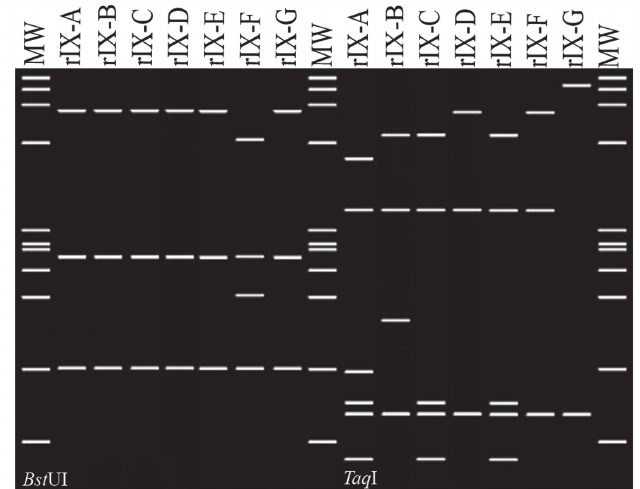
Figure 2 . Virtual R16F2nR2 RFLP patterns by key enzymes Bst UI and Taq I for distinguishing among 16SrIX sub- groups. MW, FX174DNA digested by Hae III, fragment size (bp) from top to bottom: 1353, 1078, 872, 603, 310, 281, 271, 234, 194, 118, 72.